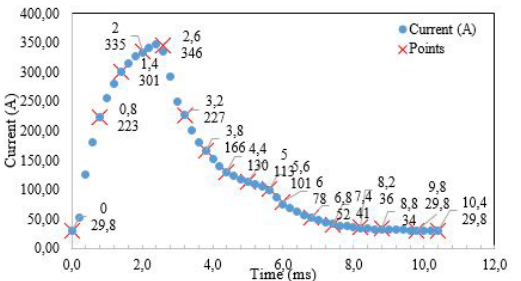
Figure 1. Fronius GMAW pulsed waveform.